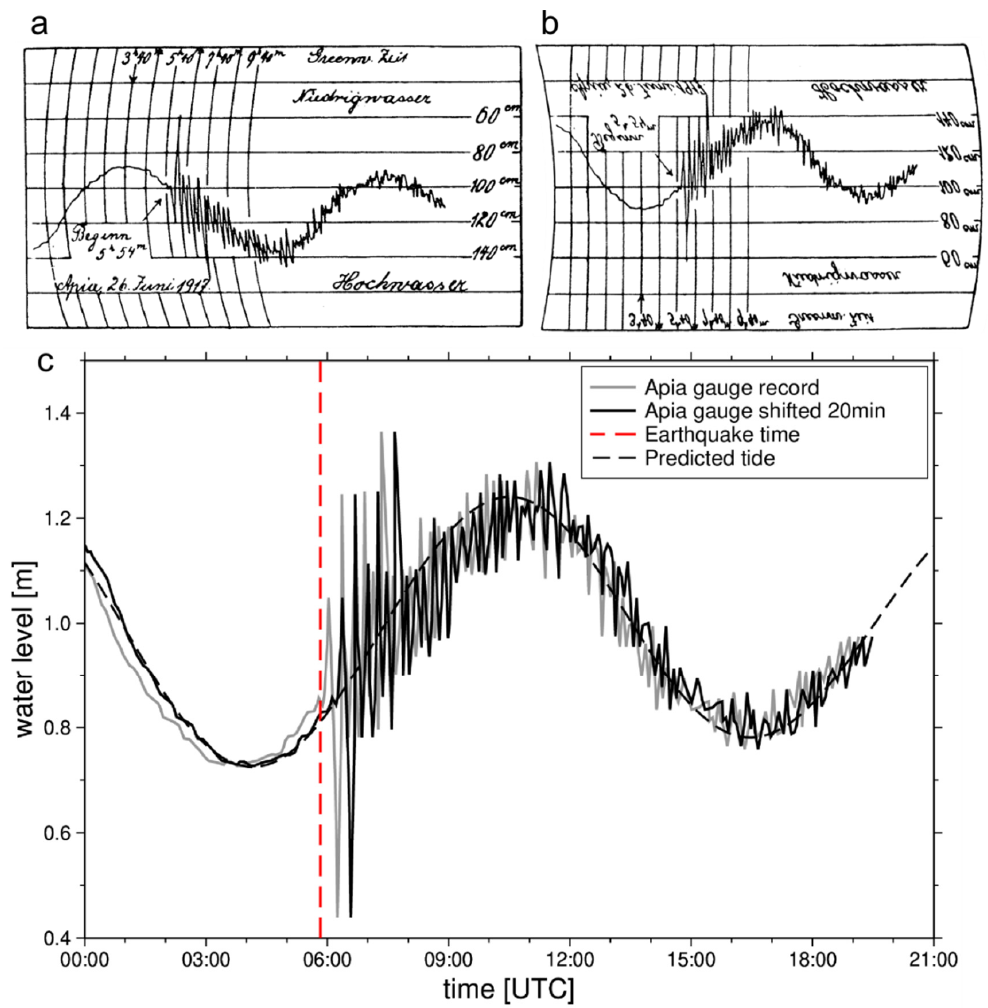
Figure 2. Tide gauge records for the 1917 tsunami in Apia harbour. ( a ) Original maregram taken from Angenheister (1920) [23]; ( b ) inverted and reprojected maregram for digitization; ( c ) digitized tide record (grey solid line) and predicted tide (black dashed line). The maregram shows the fluctuations of the sea in Apia harbour arriving only a few minutes after the earthquake. The earthquake occurred at 05:49 UTC (dashed red line), with the first noticeable sea level peak at 06:03 UTC. The maregram record prior to the earthquake better matched the predicted tide when shifting the record by 20 min (black solid line), which also produces more consistent arrival time for the tsunami.